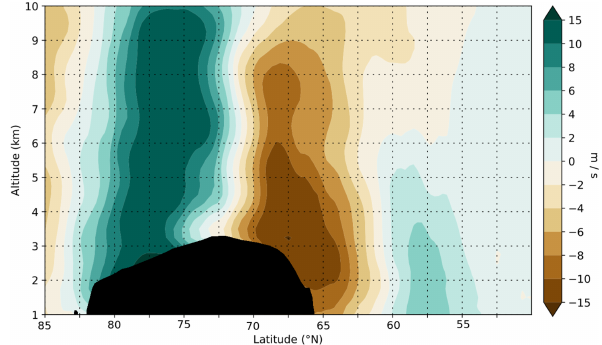
Figure 13. Difference between CTL-run and T21-run zonal ( u ) component wind at flight time. The zonal wind component rep- resents an along-ridge wind (similar to Fig. 11d from Trüb and Davies, 1995). The cross section with altitude is aligned roughly along the jet axis (see Fig. 1 for the jet) at 40 ◦ W longitude from 85 ◦ N to 50 ◦ N. Black indicates the Greenland